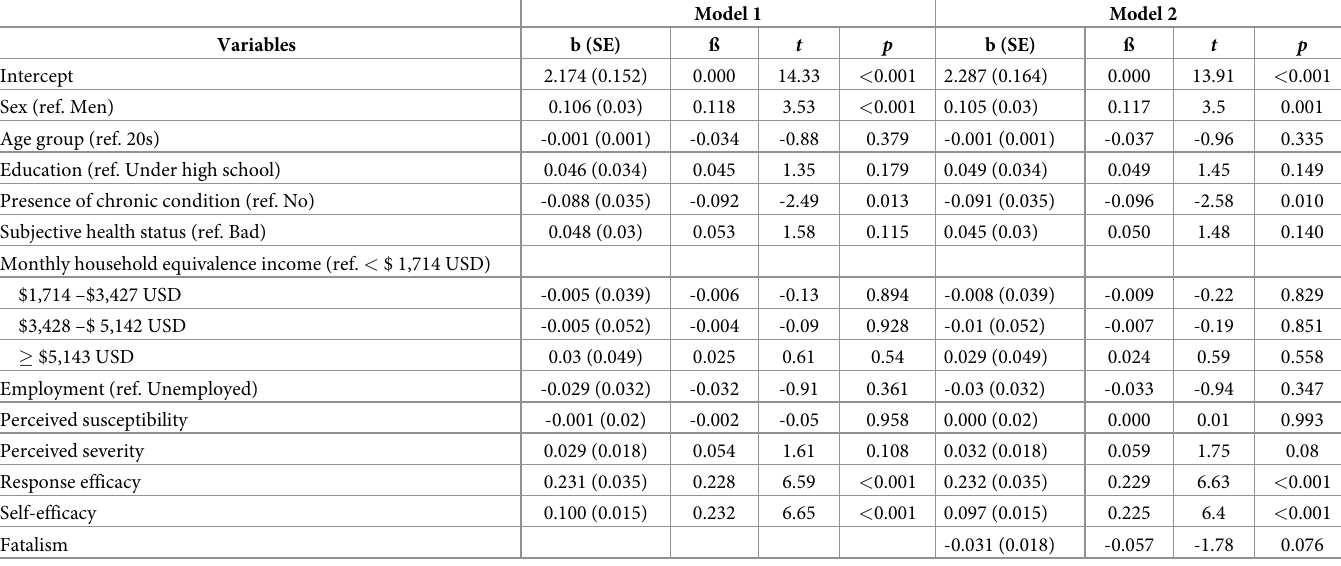
Table 4. Multiple regression analysis predicting the danger control response- personal hygiene